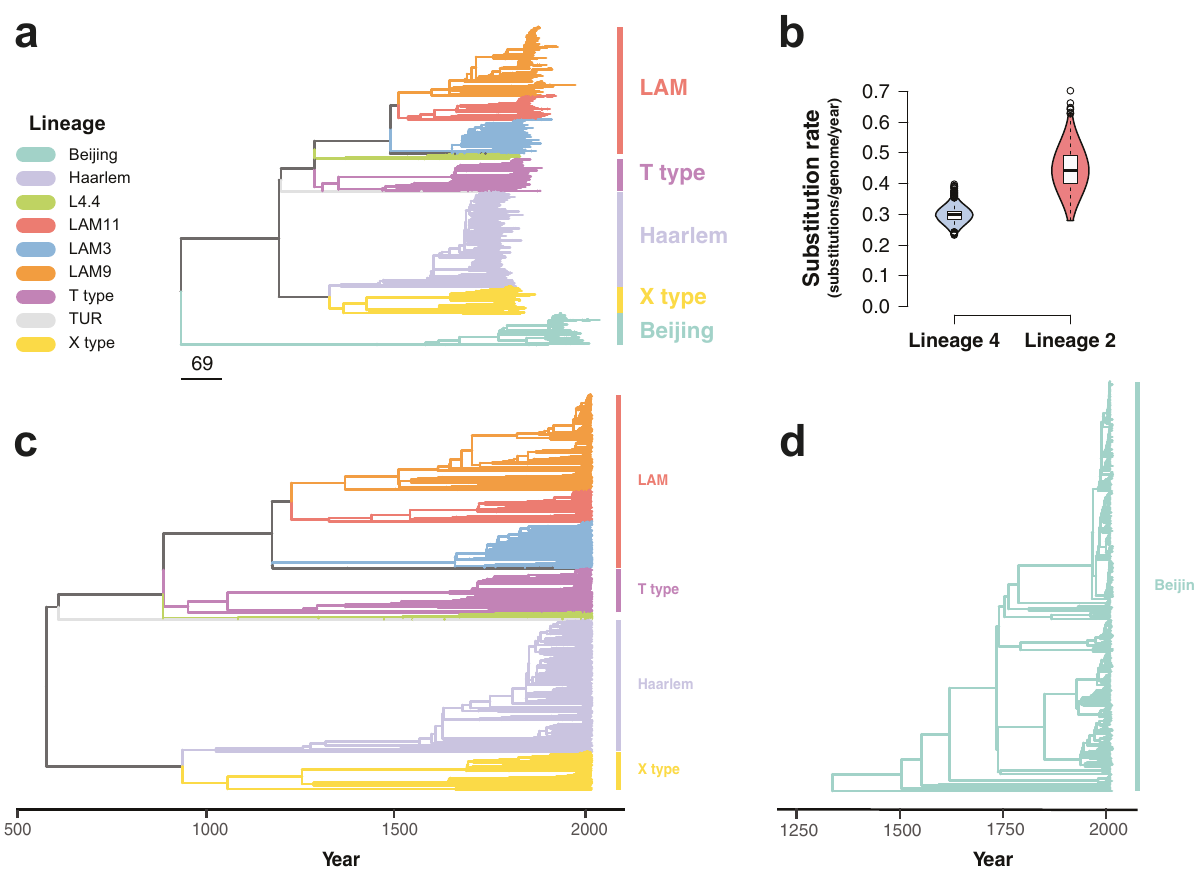
Fig. 1 Phylogenetic analysis of 3134 Mycobacterium tuberculosis isolates from Lima, Peru. Colors represent different lineages and sublineages. a Maximum likelihood phylogeny. Scale in number of substitutions per genome. b Violin plots showing the posterior density distribution of the inferred substitution rate in substitutions per genome per year derived by sampling from 10 7 MCMC iterations. The substitution rate was estimated separately for lineage 4 (blue) and lineage 2 (red). Box plots inside the violin indicate the median value of the distribution (black horizontal line) and the interquartile range. Whiskers denote 1.5x the interquartile range, while outliers are plotted as individual points. c Time-calibrated phylogeny of lineage 4. d Time- calibrated phylogeny of lineage